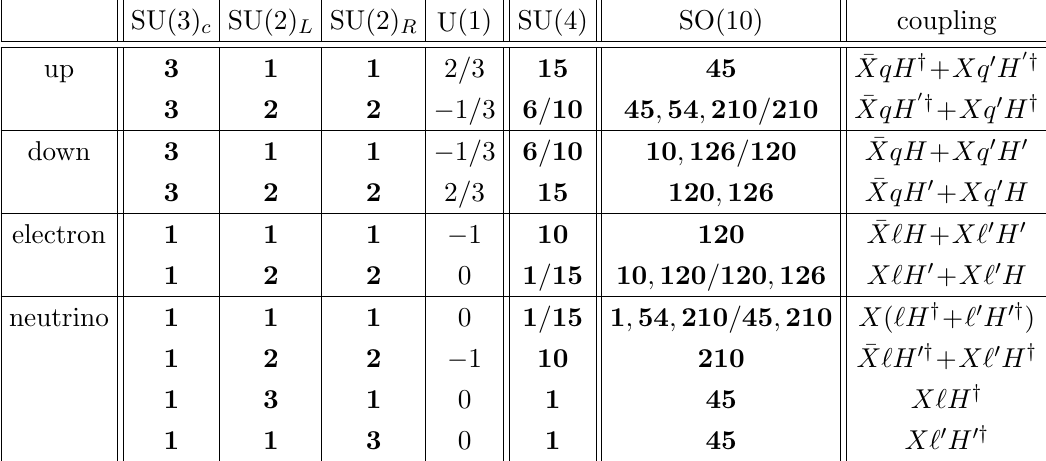
SU(2) L SU(2) R as well as the SO(10) group. (cid:2) (cid:2)